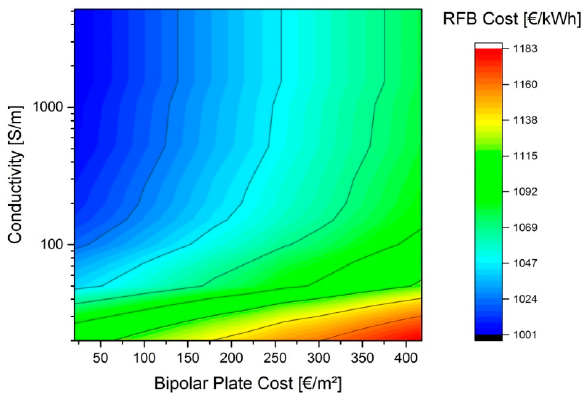
Figure 6. Influence of the conductivity and cost of bipolar plates on the system costs of a 10 kW/120 kWh vanadium redox flow battery system.